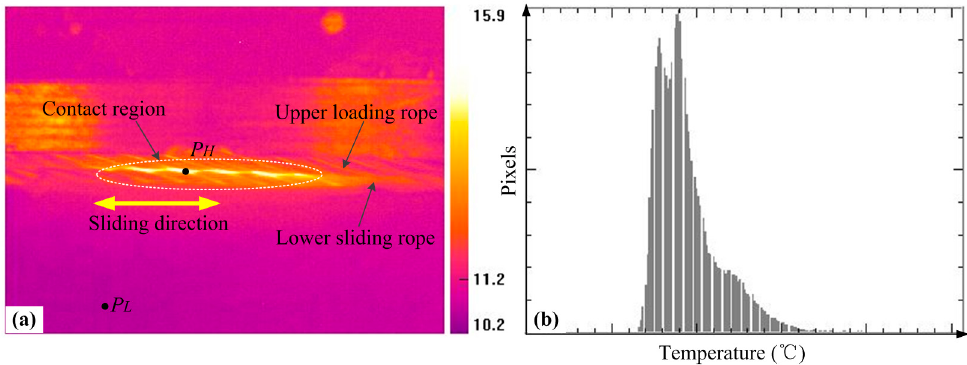
Figure 4. The infrared thermogram ( a ) and temperature distribution histogram ( b ) in the case of the right cross and the crossing angle is 7°.